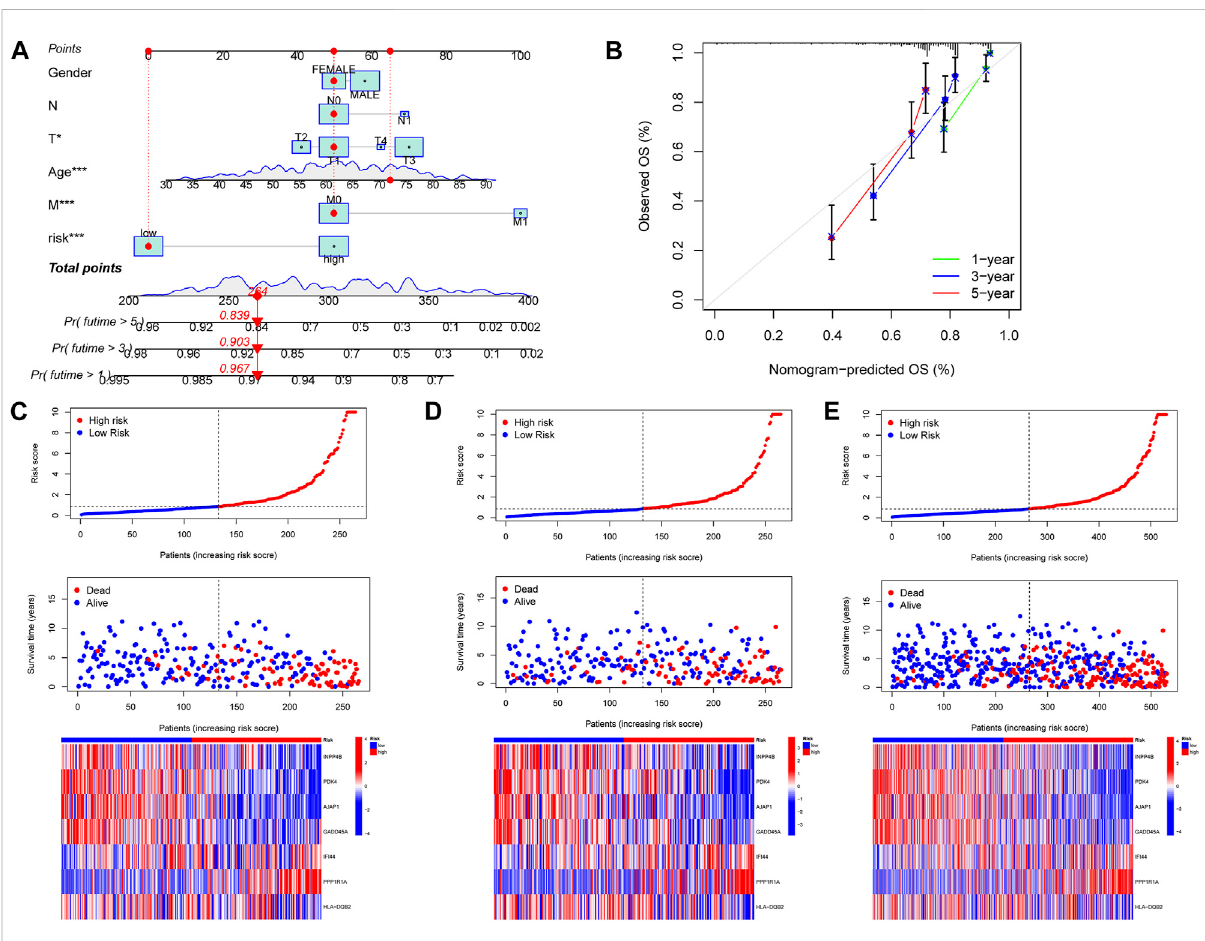
Construction of nomogram, the correlations between the m7G score and patient survival status. (A) Nomogram predicted 1, 3, and 5-year overall survival of ccRCC patients. (B) Calibration curves of the nomogram for predicting of 1-, 3-, and 5-year overall survival of ccRCC patients. (C – E) Distribution of the m7G score among ccRCC patients, correlations between the m7G score and patient survival status, risk heat map of m7G score genes, from left to right were the patients in the training group, the patients in the test group and the patients in all